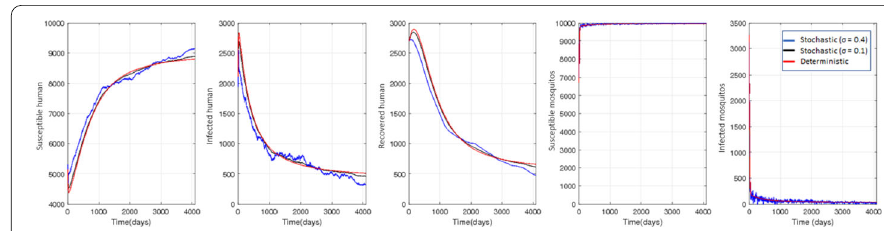
Figure 9 Model simulation with bed nets η = 0.5 and without fumigation when R 0 > 1